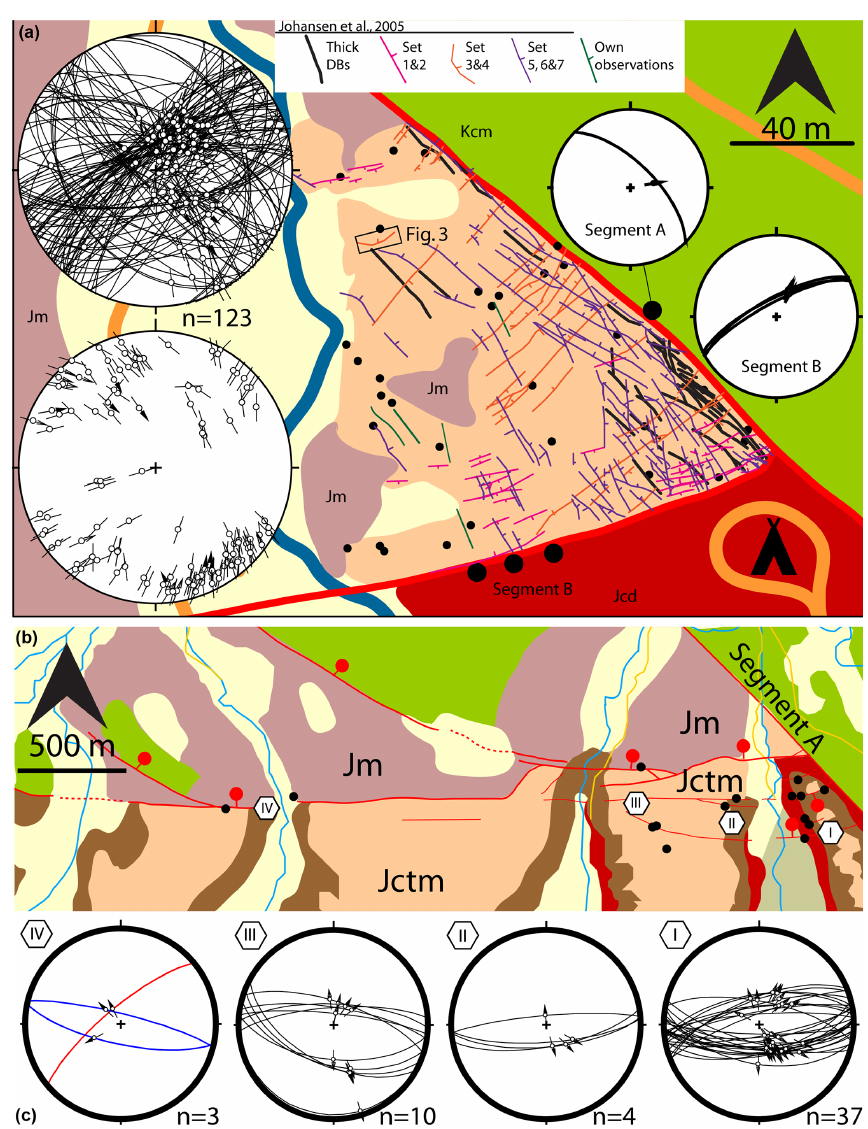
Figure 3. (a) Map of the Courthouse Junction outcrop with GPS stations (dots) of the locations where striated slip planes were measured in (33 locations; 123 measurements). A sketch map of the different sets of deformation bands is included, based on Johansen et al. (2005) and our own observations (length > 5m). Stereograms show the measured striated fault planes, as an Angelier lower-hemisphere plot and as a Hoeppener plot. The small stereograms show faults and striations in the two fault segments. See Fig. 1 for key. Panel (b) is the same as (a) but along Segments B and C, at 15 stations with 60 measurements (separated in four locations; I–IV). (c) Stereonets for these